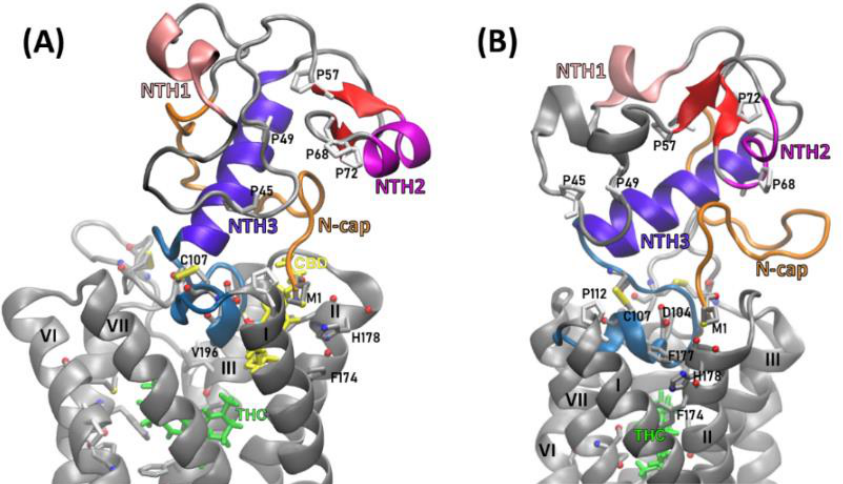
Figure 7. CB 1 receptor N-terminal domain conformation depends on CBD presence in the allosteric site. ( A ) CB 1 R with CBD and THC bound, ( B ) CB 1 R with THC bound only; cyan — MPR, violet — N-terminal helix 3 (NTH3, residues 80 – 94), red —a parallel β -sheet (residues 58 – 60 and 72 – 74), ma- genta — N-terminal helix 2 (NTH2, residues 61 – 69), salmon — N-terminal helix 1 (NTH1, residues 30 – 35), orange — N-terminal cap (residues 1 – 20). Proline residues are shown as white sticks.